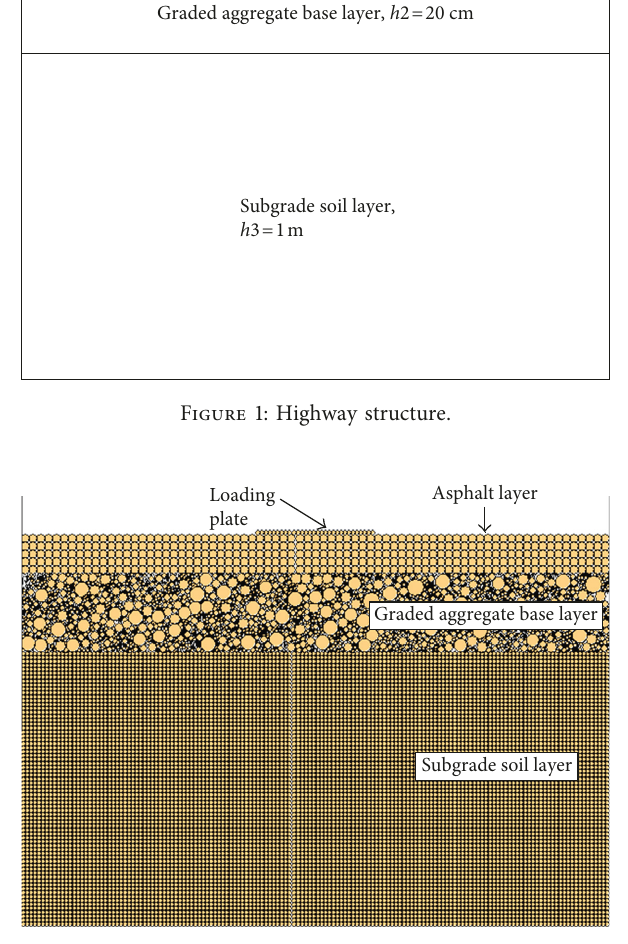
Figure 2: Numerical